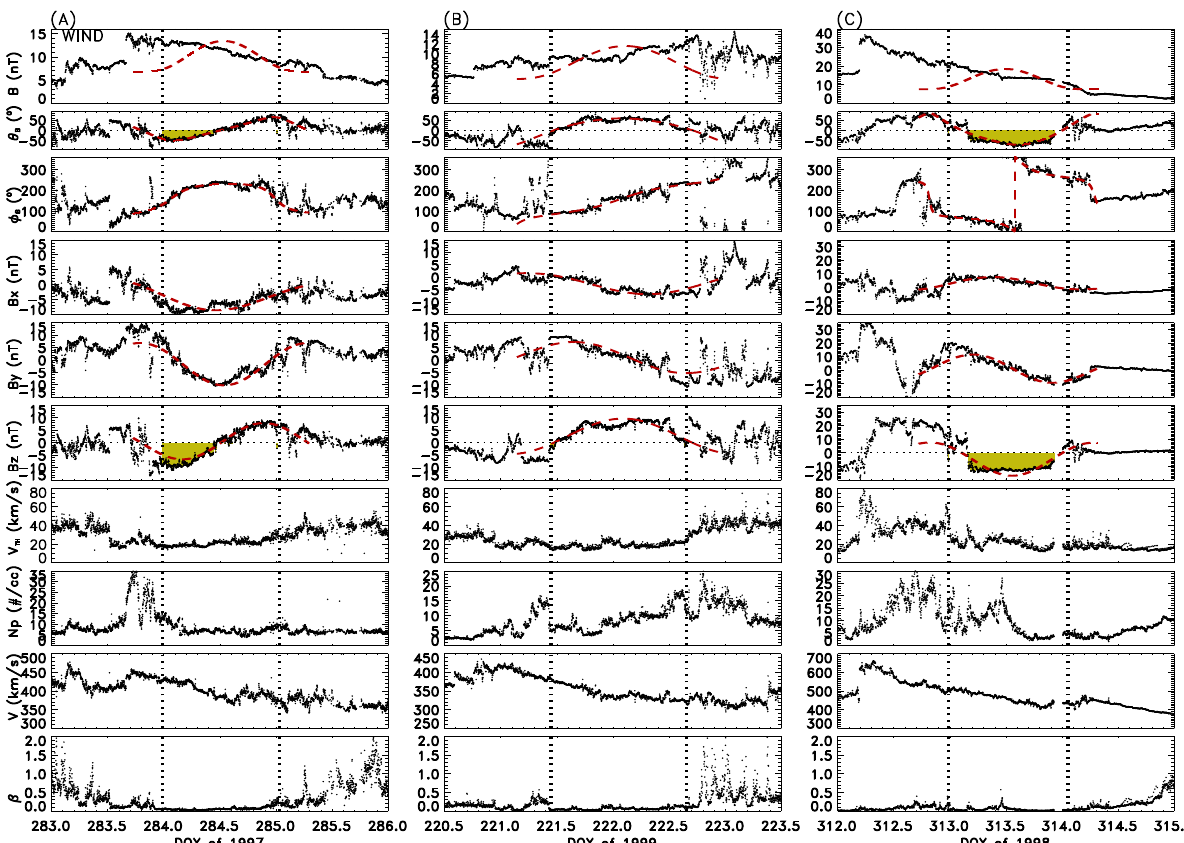
Fig. 1. Typical magnetic cloud (MC) field and plasma profiles in terms of magnetic field magnitude (B) , latitude ( θ B ) , and longitude ( φ B ) , B X,Y,Z (GSE) components, thermal speed (V Th ) , bulk speed (V), proton number density (N P ) , and proton plasma beta ( β P ) - in that order from top to bottom. The vertical lines indicate start and end times of the MC, and the (red) dashed curves are model-fits to observations, to be explained below. The regions shaded in yellow are where the observed B z components are southward. (A) A case of a MC (starting on 10 October 1997 (Day 283) at 23.80 UT, with duration 1 T of 25.0h) estimated to be closely aligned with the Y GSE -axis within about 2E (this is a S → N type, i.e. Category 11 MC as described in Table 3), (B) another MC (starting on 9 August 1999 (Day 221) at 10:45 UT, with a duration of 29.0h) estimated to be strongly inclined (positively) with respect to the ecliptic plane by 76 ◦ , and finally a third (C) starting on 8 November 1998 { Day 312 } at 23:45 UT, with a duration of 25.5h) estimated to be strongly inclined (negatively) with respect to the ecliptic plane by − 71 ◦ . All three of these MCs are classified as Q 0 =1 cases, to be described below. Notice that case (A) has a uniform proton density, case (B) has an increase in density at the end of the MC, and case (C) has an increase in density in the early portion of the MC. This irregularity of density generally in MCs is the reason for not including density in the definition of a